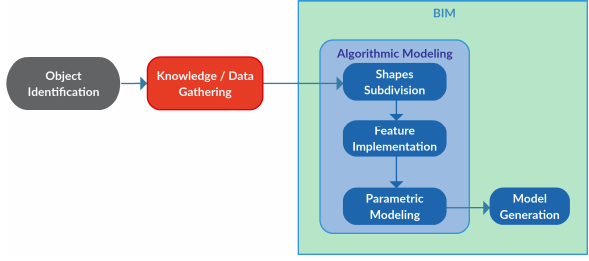
Figure 3. Algorithmic modeling